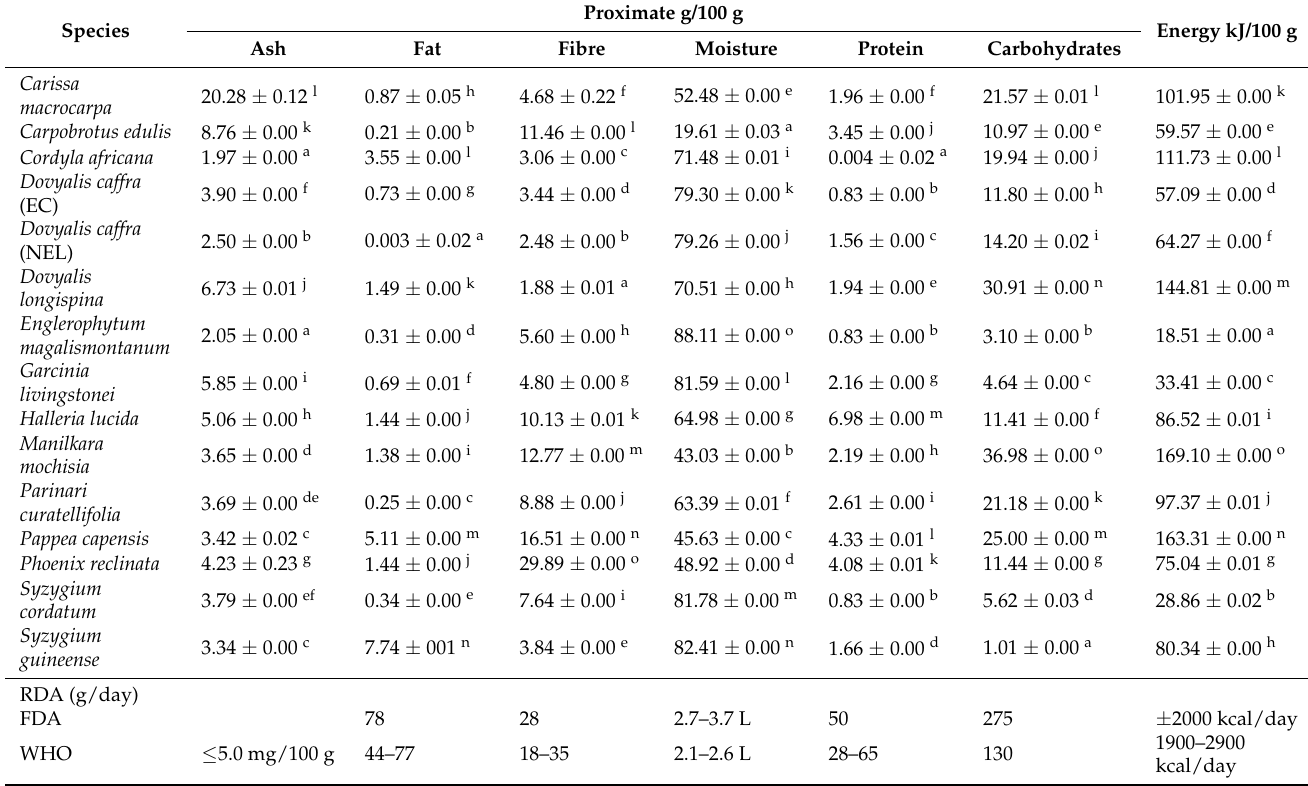
Table 3. List of wild indigenous fruit plants and proximate value, as well as Recommended Daily Allowance (RDA) range values in